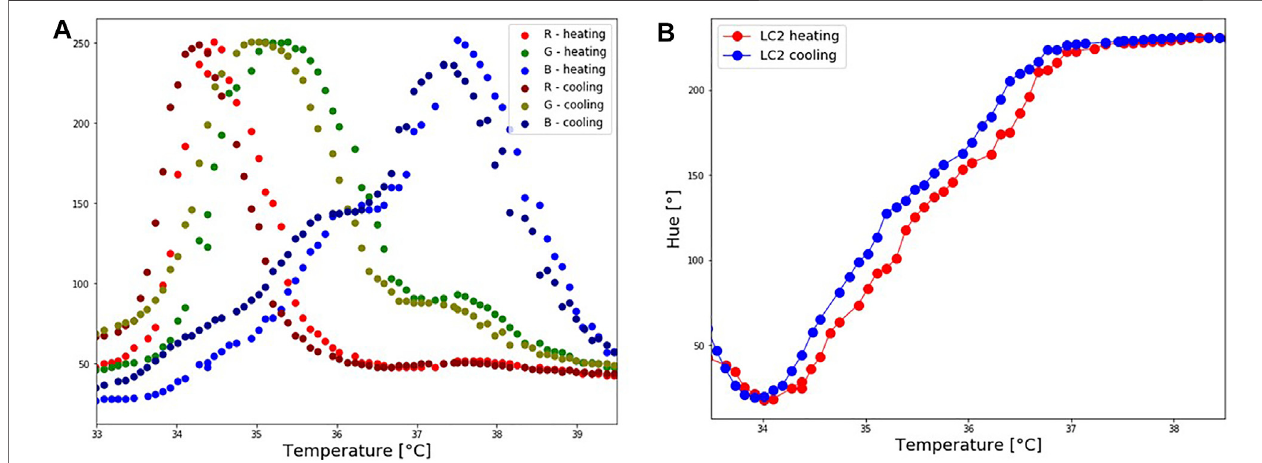
FIGURE7| LC2patch:Hysteresiseffect.Thepatchwas fi rstheateduntilreachingtheisotropicphase,andcooleddown. (A) ShiftinRGBvaluesduringthecooling process. (B) A corresponding shift in Hue values during the cooling process.